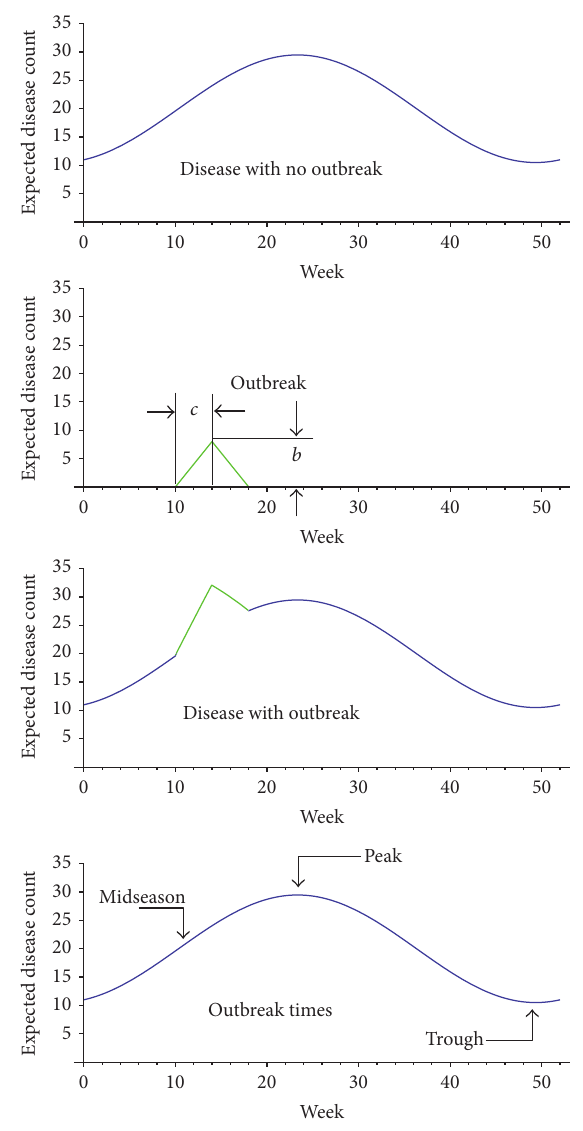
Figure 4: Illustration of typical outbreak and its effect on the expected disease count. The bottom figure shows the outbreak times used in the